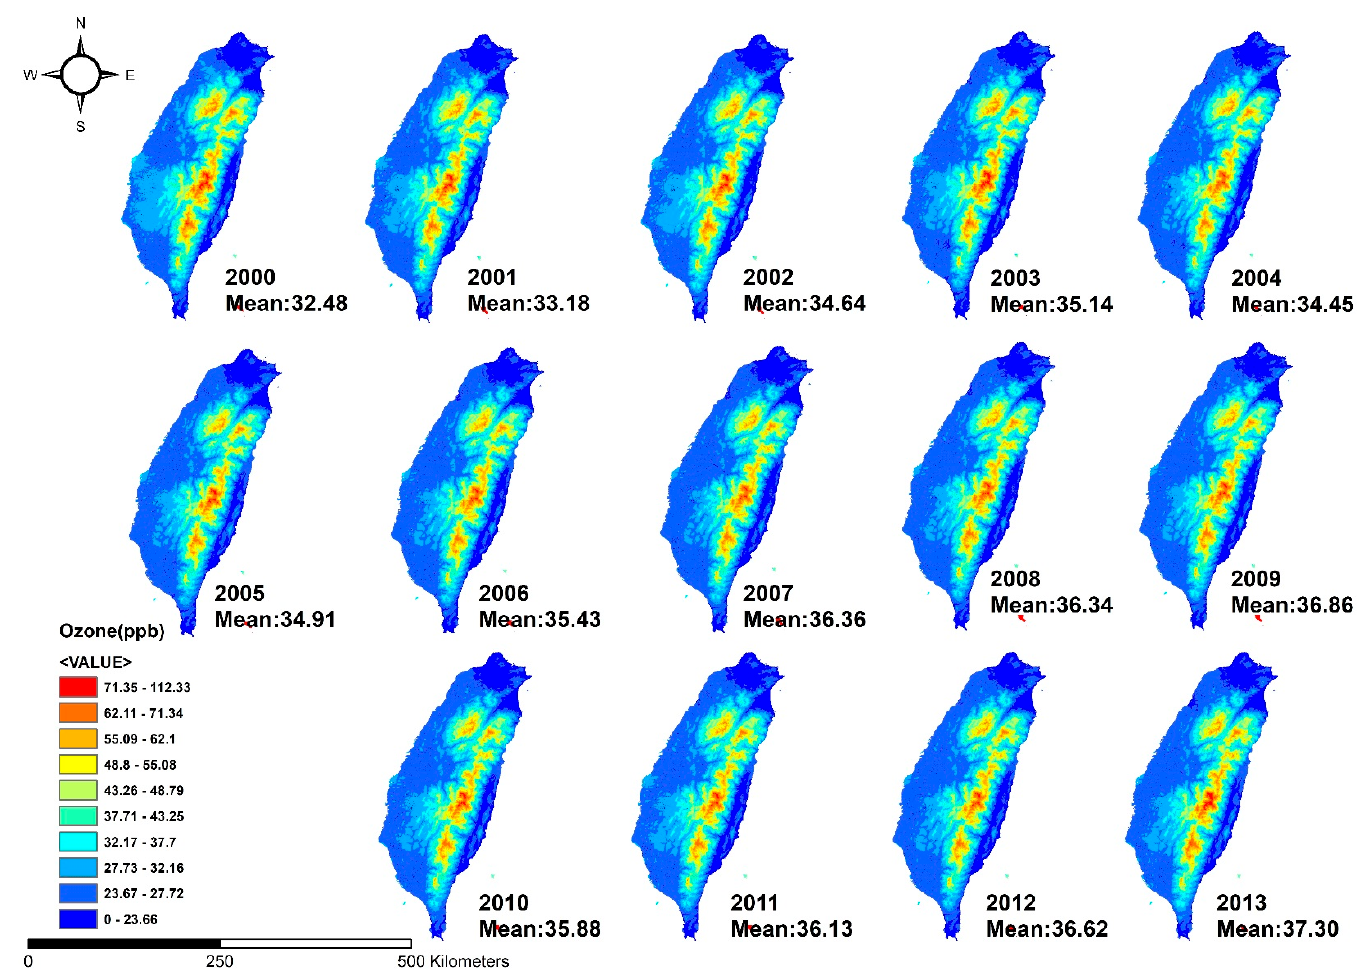
Figure 3. Annual average O 3 concentration for the entire study period as simulated by the developed model.